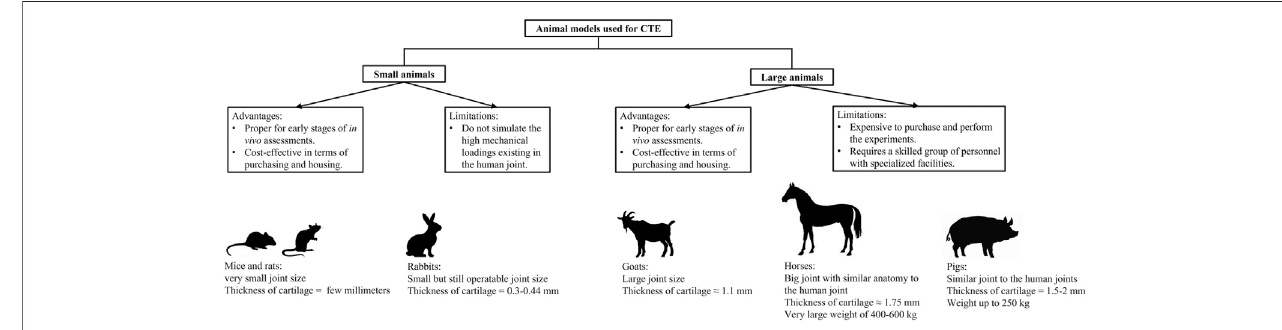
FIGURE1| SummaryofinformationforadvantagesandlimitationsofsmallandlargeanimalmodelsusedinCTE.Speci fi ccharacteristicsforseveralanimalmodels are also presented in the fi gure (images for this part were generated from https://www.istockphoto.com).